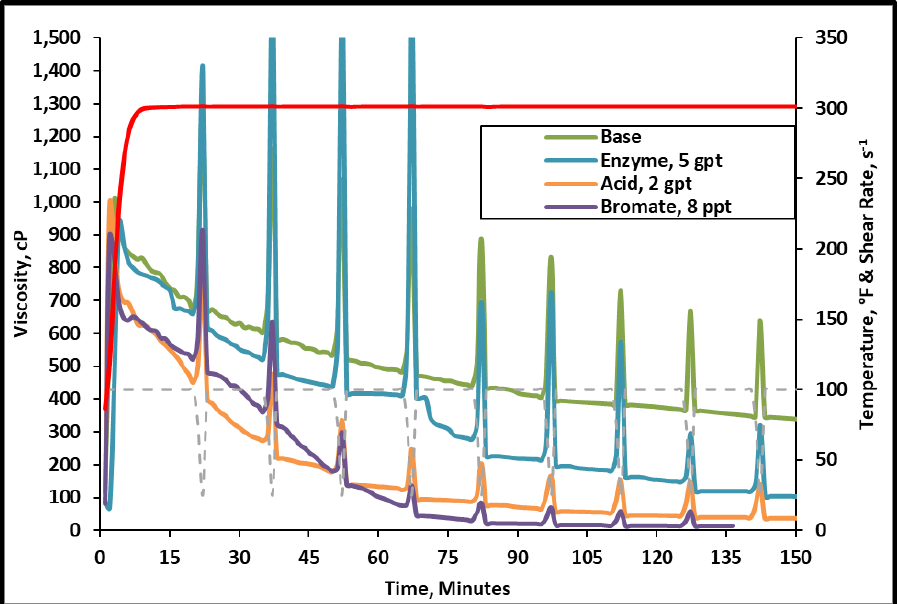
Figure 4. Viscosity of 45 lb/1000gal crosslinked fracturing fluid as a function of gel breaker type at 300 °F.